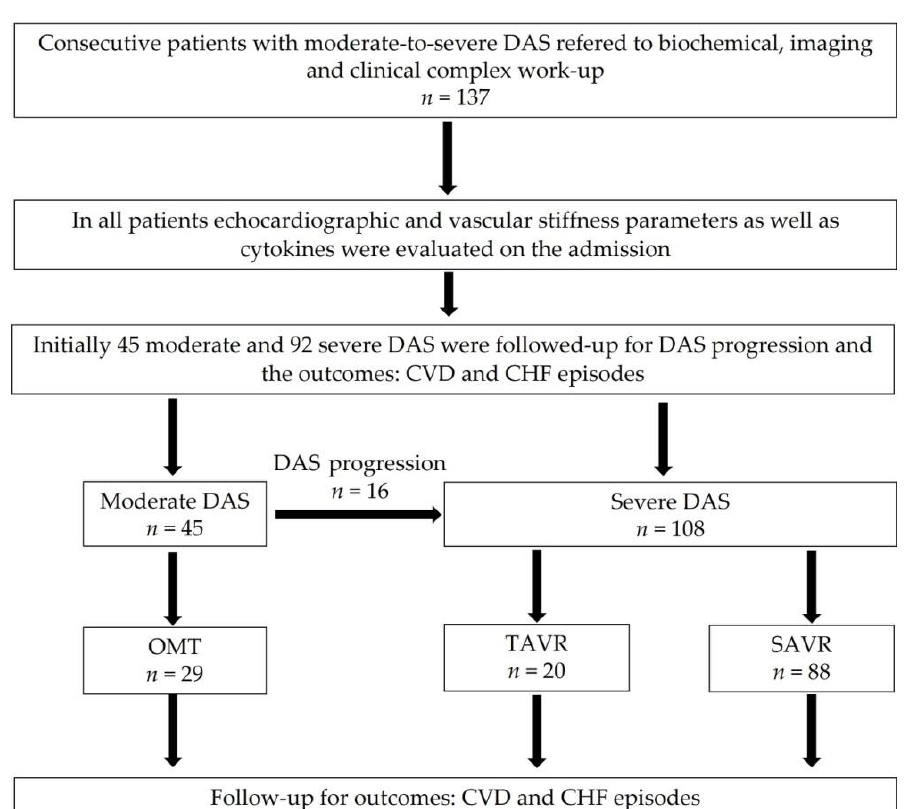
Figure 1. Study flowchart. Abbreviations: CHF, chronic heart failure; CVD, cardiovascular death; DAS, degenerative aortic stenosis; OMT, optimal medical treatment.